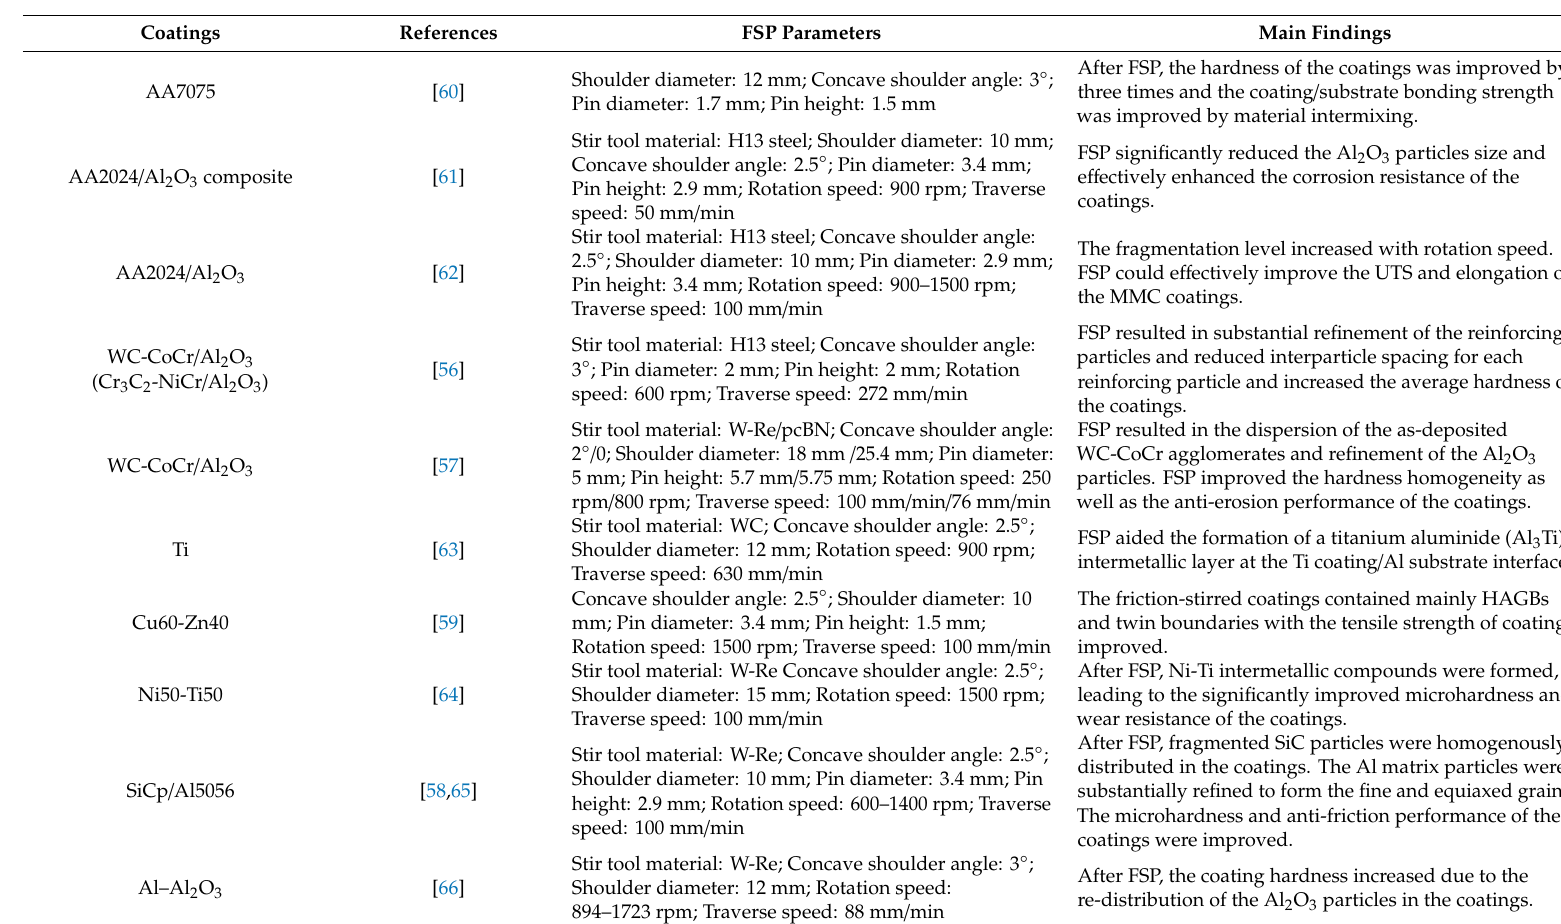
Table 2. E ff ect of friction stir processing on cold sprayed